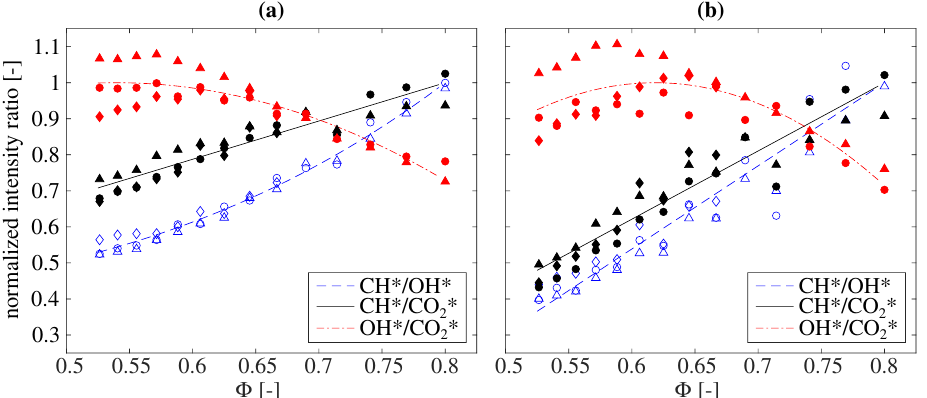
Figure 4. The dependence of different normalized chemiluminescence ratios on the equivalence ratio Φ for the combustion of kerosene under atmospheric conditions. The intensities of CH* and OH* are uncorrected in ( a ) and background corrected in ( b ). Various thermal powers are marked with symbols (diamond: 40kW, circle: 50kW, and triangle: